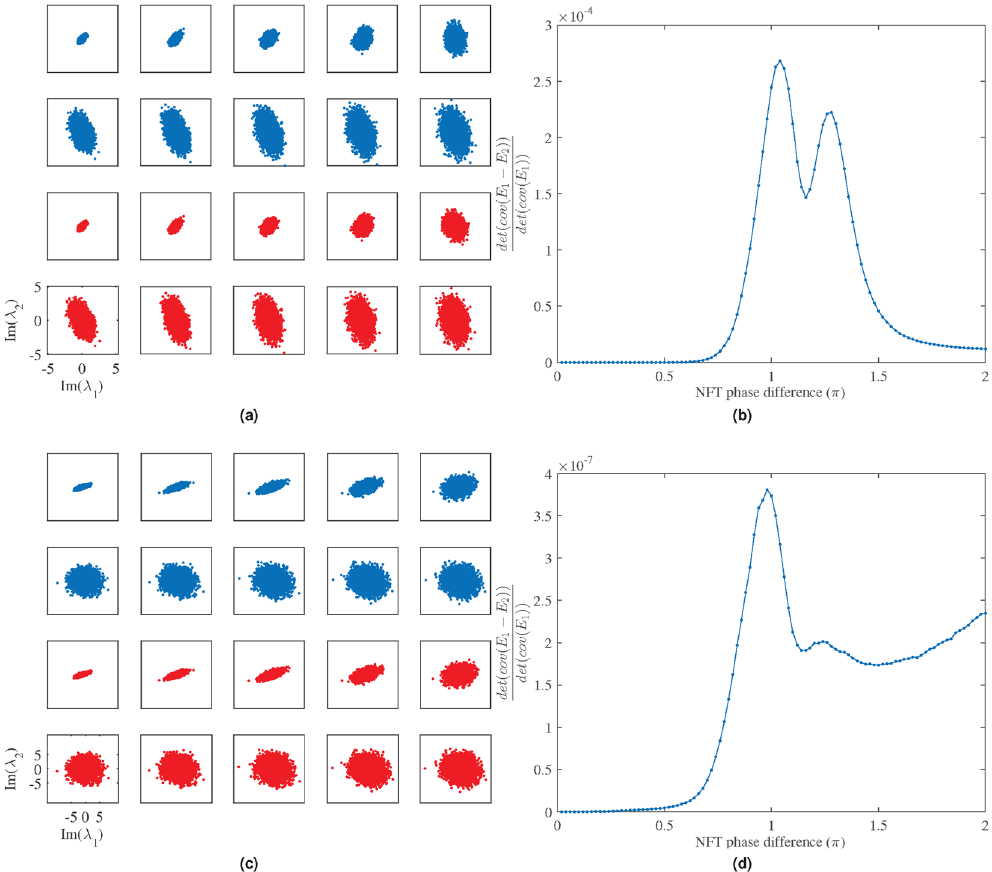
Figure 8. Comparison of the accumulated perturbations with (top blue) and without (bottom red) the approximation Eq. (16) for m values ranging from 0.2 π to 2 π with a step of 0.2 π . ( a ) 2 sech ( t ) pulses, ( b ) relative error of the approximation with 2 sech ( t ) pulses, ( c ) square pulses with width of 10 and height of 0.5, ( d ) relative error of the approximation with the square